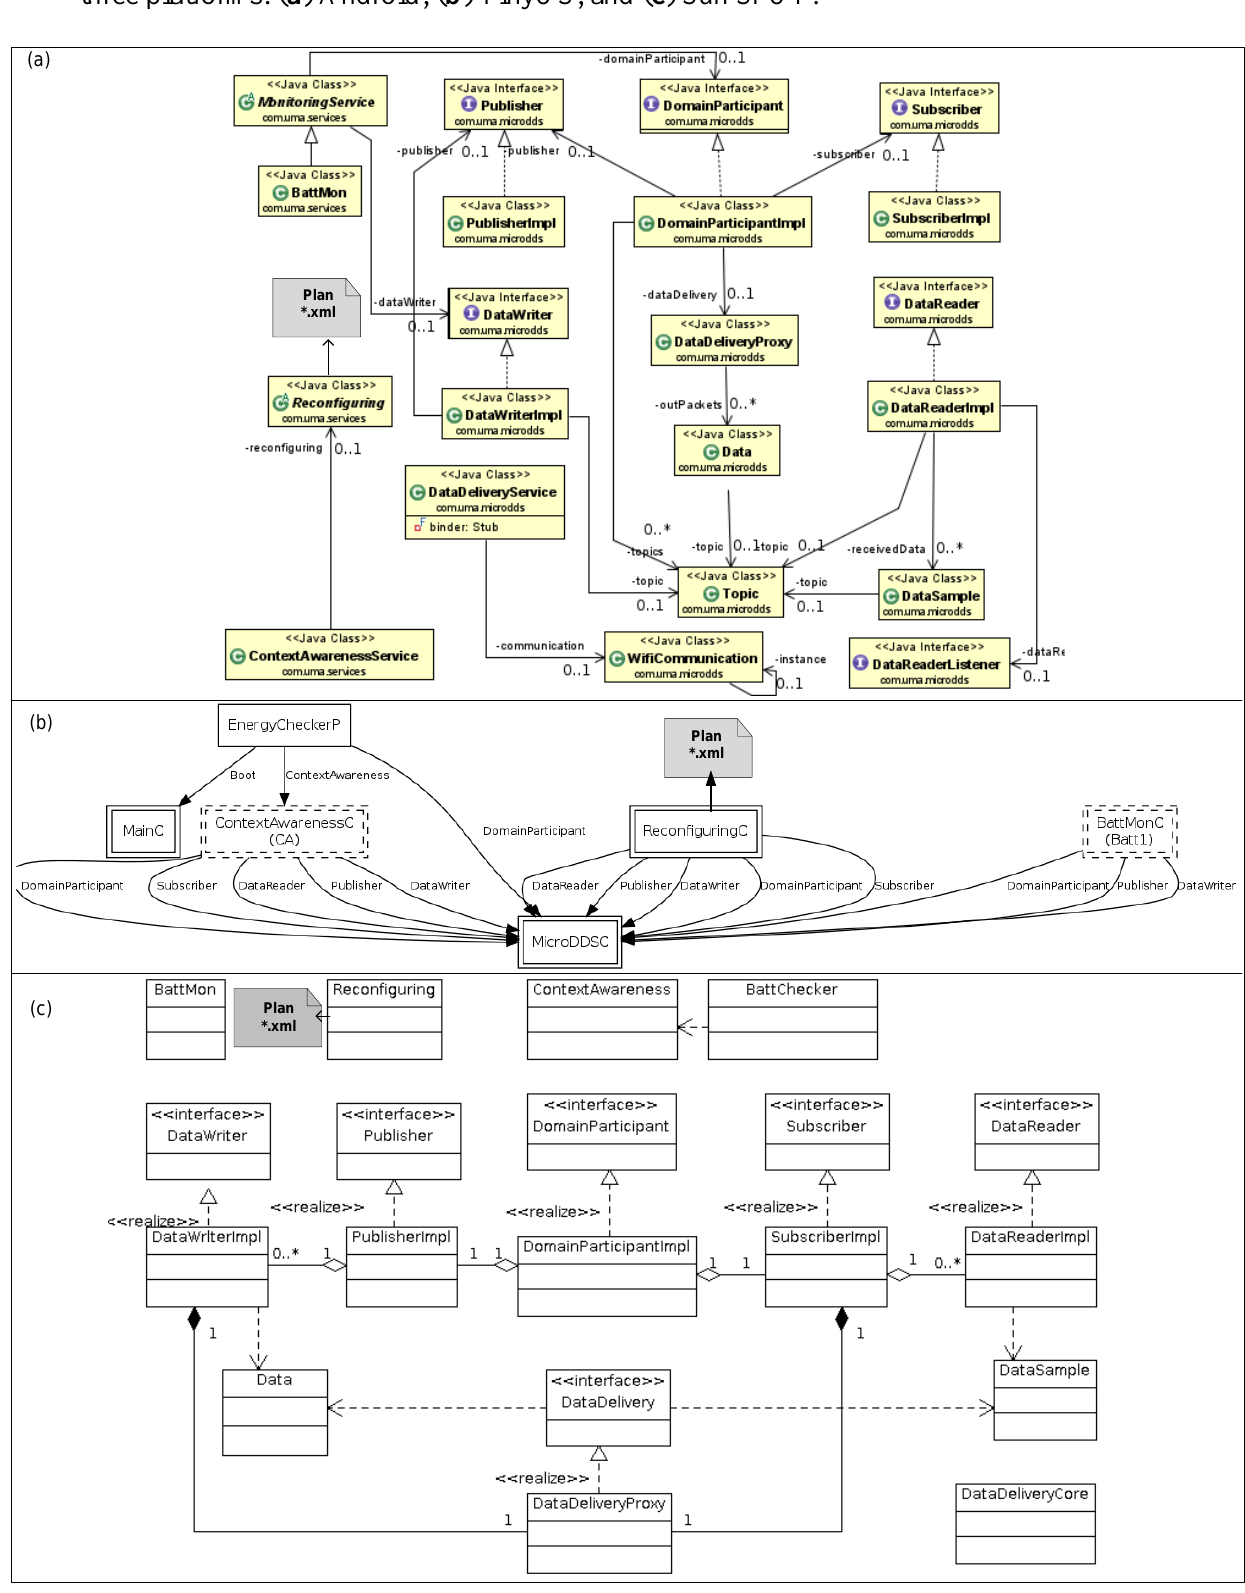
Figure 9. FamiWare instantiations with monitoring and context-awareness services for three platforms: ( a ) Android; ( b ) TinyOS; and ( c ) Sun